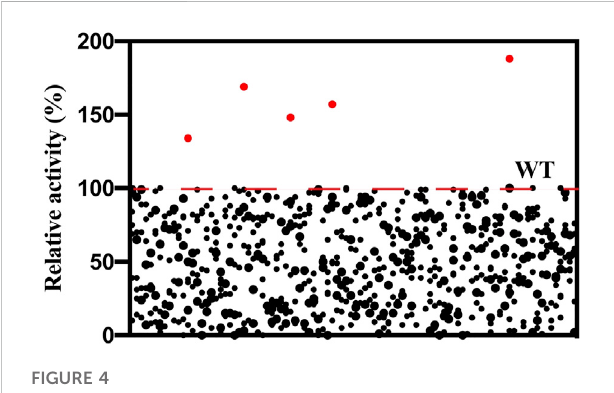
FIGURE 4 Screening of the random mutagenesis library of L -PpTA. Red dots represent the selected mutants.